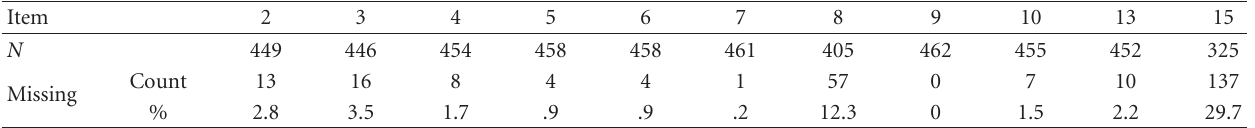
Table 2: Overview of missing values for each item (first version).